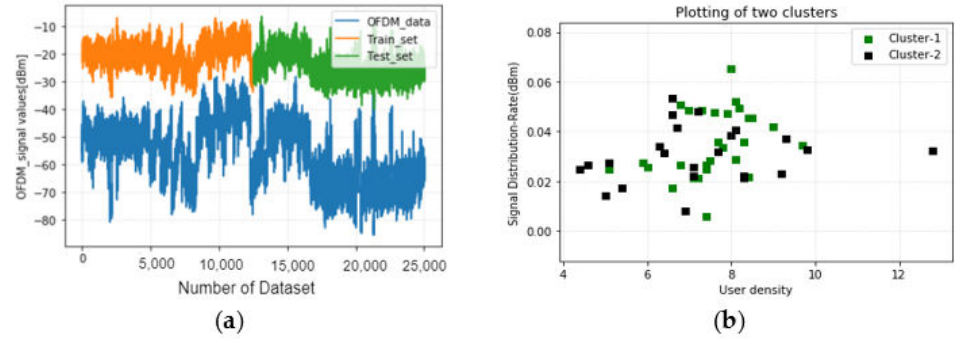
Figure 7. ( a ) Training vs. testing evaluation based on deep reinforcement learning (DRL); ( b ) Illustra- tion of clustering classes.